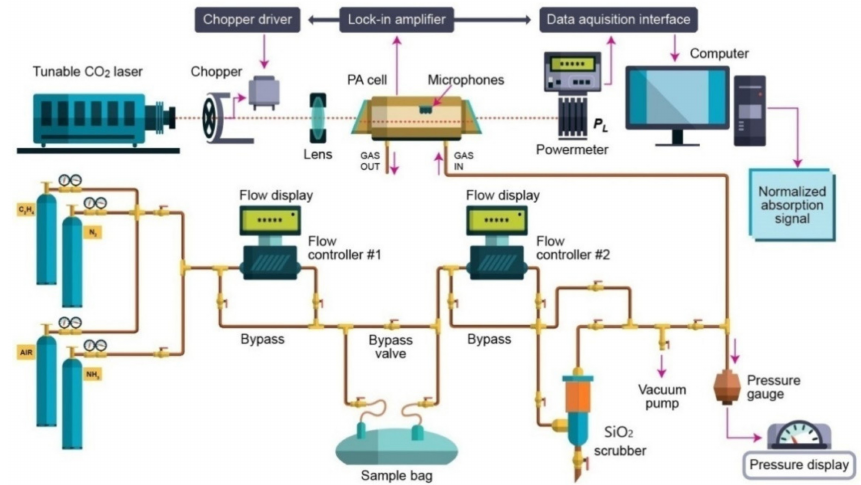
Figure 1. The photoacoustic system for the study of the SiO 2 adsorption from human respiration. C 2 H 4 human breath samples were measured before and after passing through the SiO